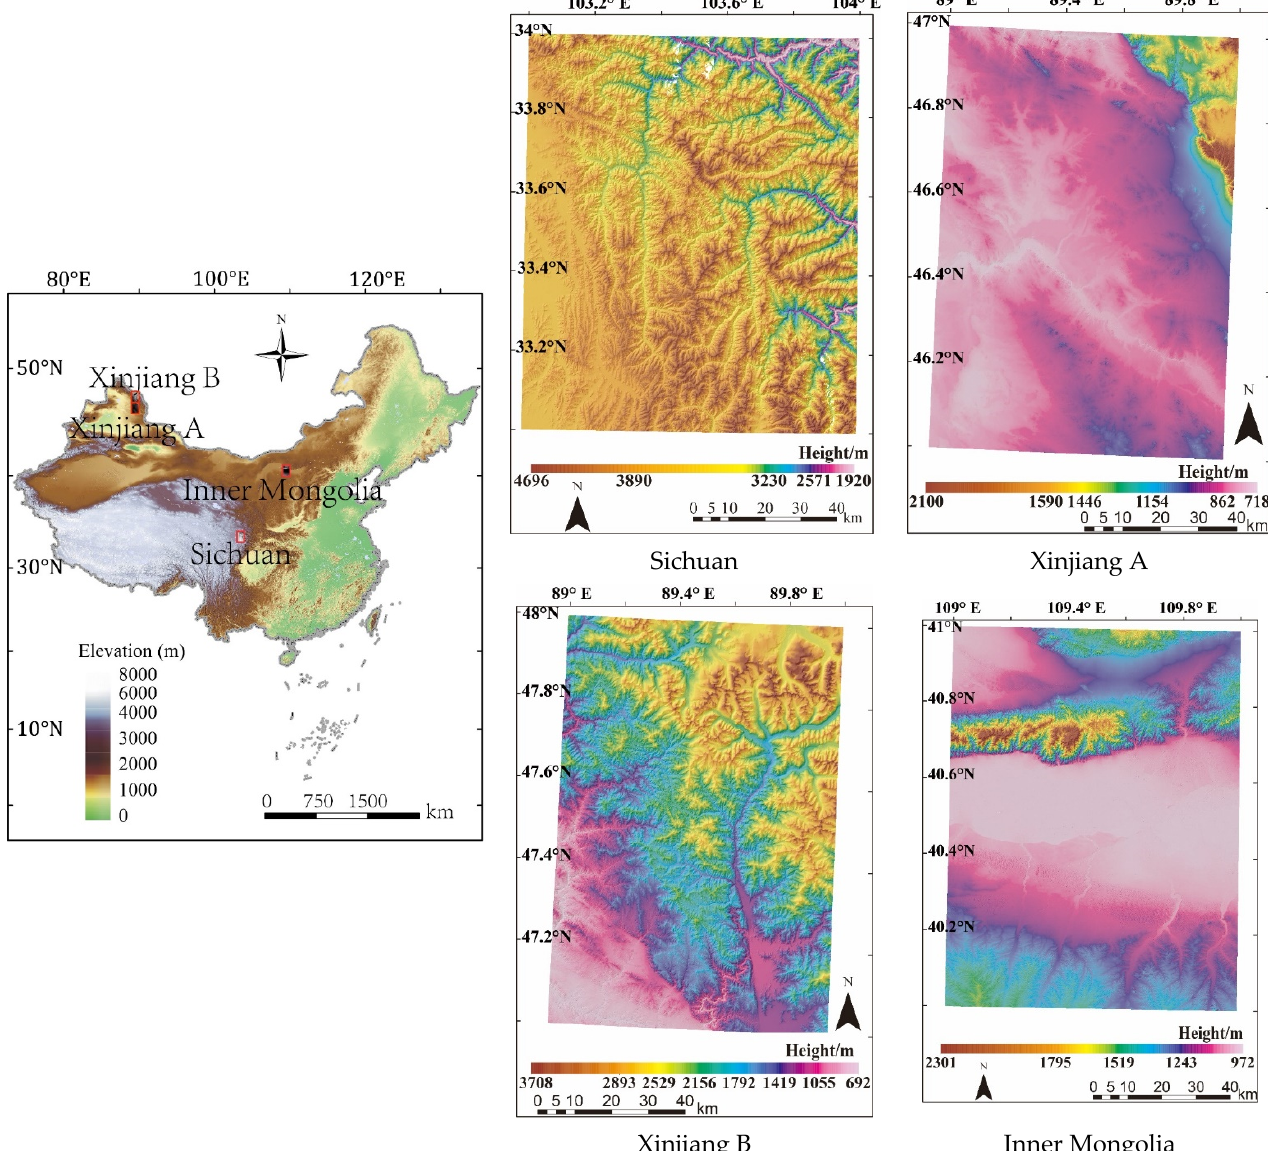
Figure 1. The location distribution of four study areas in China and images of their topography (generated from 12-m TanDEM-X DEM).